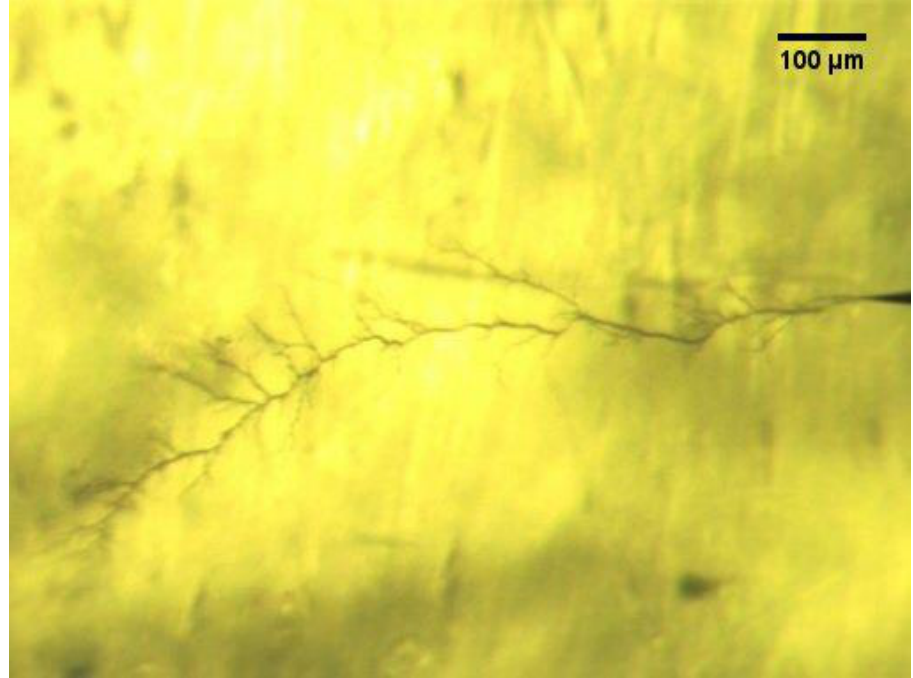
Figure 8. Electrical tree developed at positive voltage with firing angle of 60 degrees.